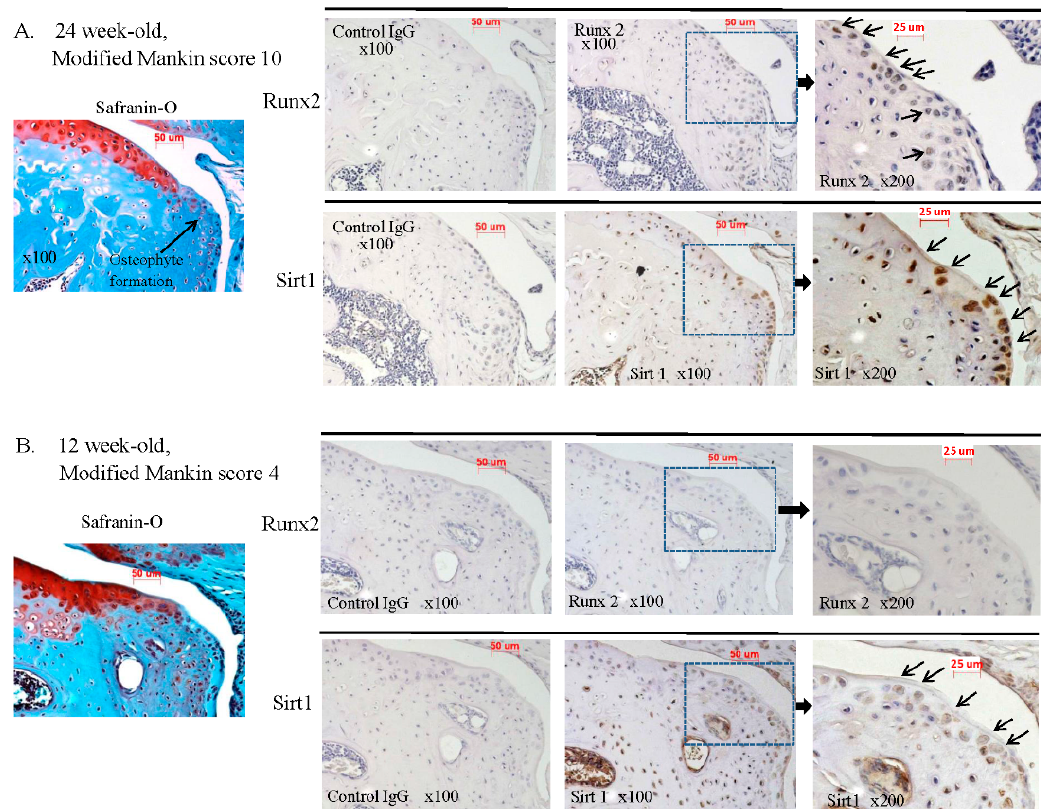
Figure 4. Representative images for Runx2- and Sirt1-immunostaining in mouse OA articular cartilage. ( A ) Representative images of Safranin O staining and Runx2- and Sirt1-immunohistologic staining in severe OA articular cartilage from 24-week old STR/OrtCrlj mice; Safranin O staining (×100), Runx2 immunostaining (×100, ×200), Sirt1 immunostaining (×100, ×200). A higher expression pattern of Runx2 was observed at the osteophyte region in the severely degenerated cartilages. Arrows indicate the Runx2- or Sirt1-immunopositive chondrocytes; ( B ) Representative images of Safranin O staining and Runx2- and Sirt1-immunohistologic staining in moderate OA articular cartilage from 12-week old STR/OrtCrlj mice; Safranin O staining (×100), Runx2 immunostaining (×100, ×200), Sirt1 immunostaining (×100, ×200). Almost of the mildly degenerated cartilages were negative for Runx2 immunostaining in 12-year old mice. Sirt1 was ubiquitously detected in chondrocytes of both normal articular cartilages and degenerated articular cartilages, regardless with or without osteophyte formation. Arrows indicate the Runx2- or Sirt1- immunopositive chondrocytes.